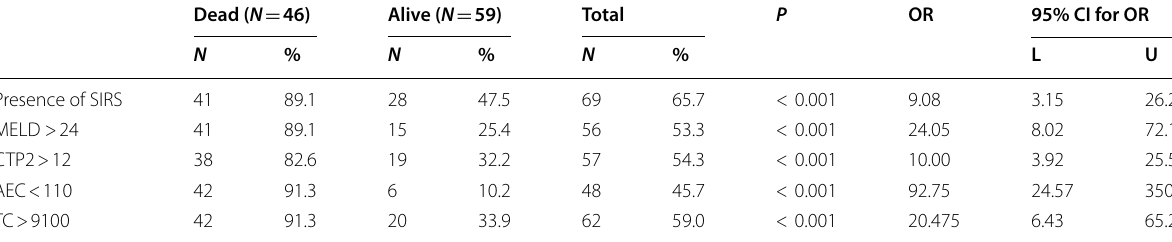
93%). The AUROC was better than other variables like count can be measured, and AEC is a cheap marker when total leukocyte count, CTP, MELD, and albumin. Uni- compared to other markers of sepsis like CRP and proc- alcitonin. CRP is considered to be an inconclusive marker variate analysis showed that the odds ratio in predicting of sepsis in chronic liver disease. The statistical analysis of in-hospital mortality was highest for absolute eosinophil our study suggested that CRP is an inappropriate marker count (92.75) compared to MELD (24.05), total leukocyte in predicting mortality in chronic liver disease patients. count (20.475), CTP(10), and SIRS (9.08). The study by Abidi et al. showed the significance of eosinophil count for diagnosing sepsis and AEC performed better than CRP in this regard [5]. There are similar studies showing the eosinophil count as a predictor of mortality in vari- ous other populations like critically ill non-cardiac vas- cular surgery patients [6] and COPD patients [7] and in positive predictive value 87.5%, negative predictive value predicting unexpected readmission and mortality in ICU Table 5 Univariate analysis of various factors in predicting mortality Dead ( N =